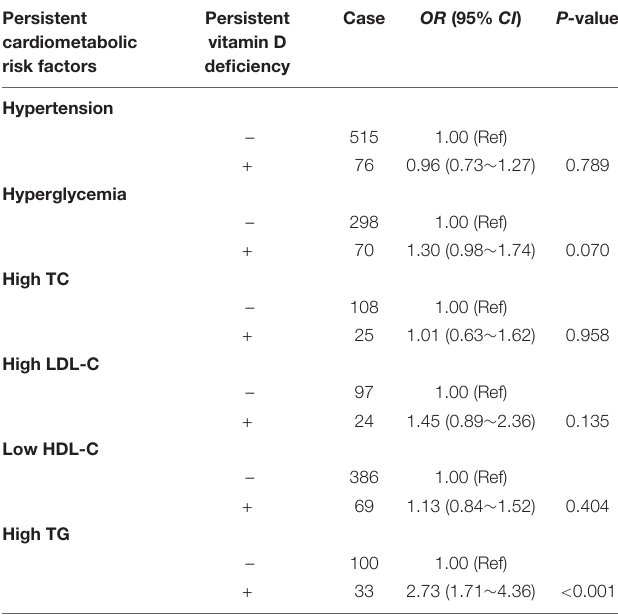
TABLE 4 | Associations between persistent vitamin D deficiency and persistent cardiometabolic risk factors [ OR (95% CI )] a . Persistent